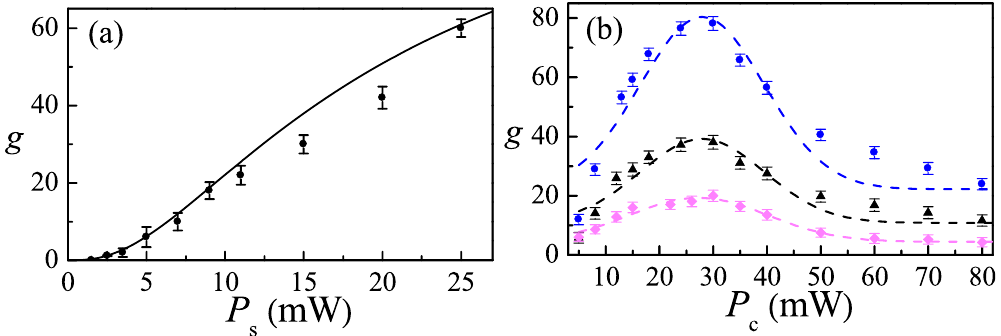
Figure 5. ( a ) Gain vs P s for P c = 30 mW; ( b ) Gain vs P c for different P s : 30 mW (blue circles), 20 mW (black triangles), and 10 mW (pink squares). Other parameters are the same as those in Fig. 4(b). Solid curve is the theoretical